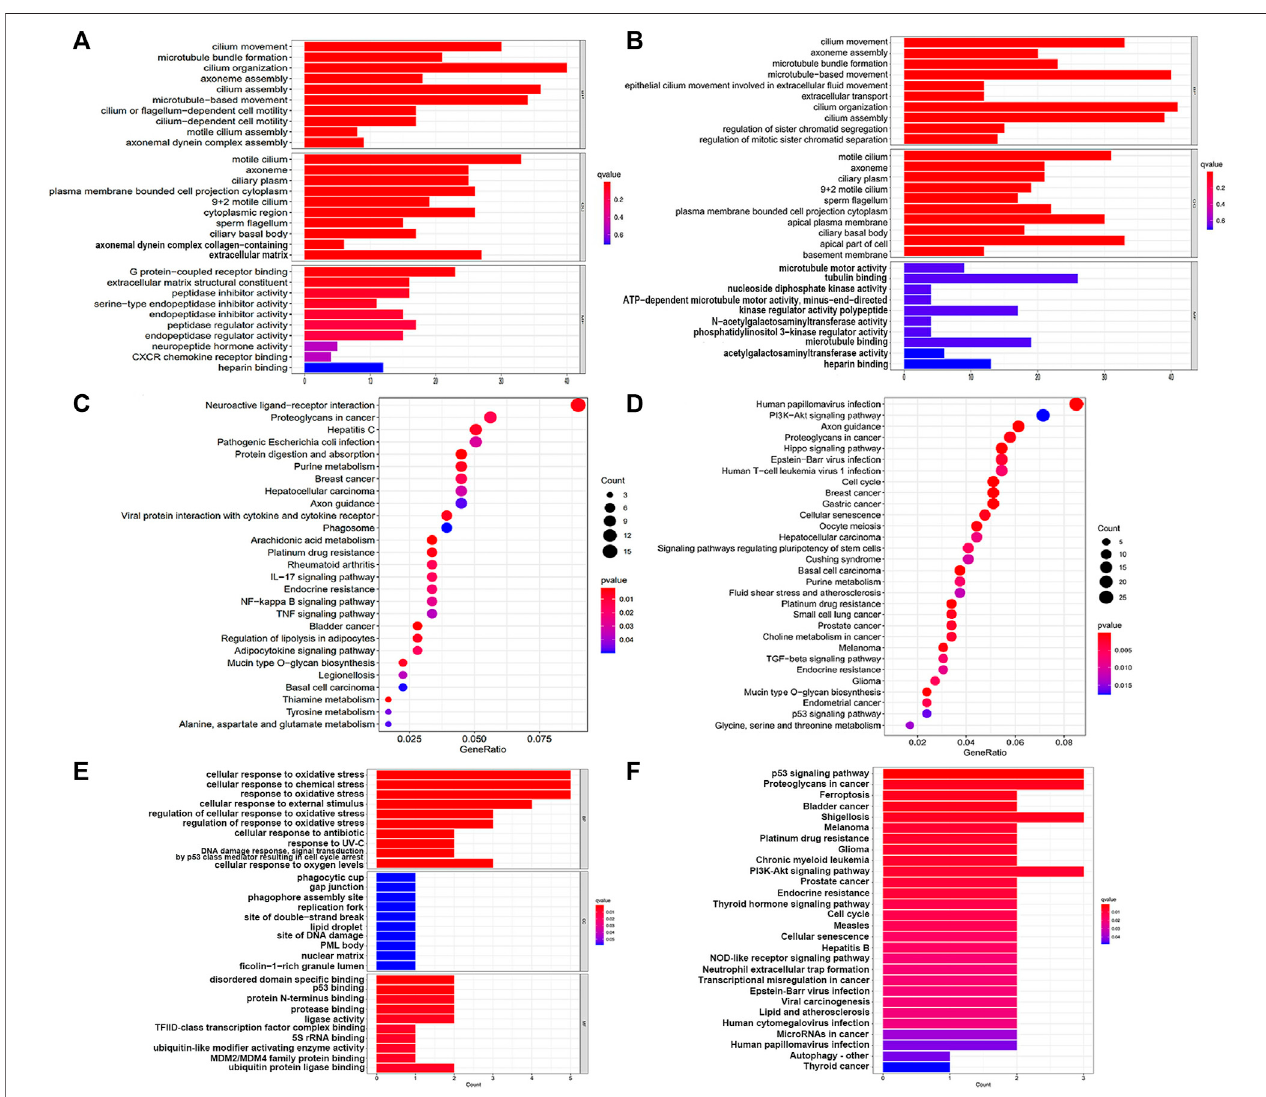
FIGURE 3 | GO and KEGG enrichment analysis results. (A , C) GO and KEGG pathway enrichment analysis in the training cohort; (B , D) GO and KEGG pathway enrichment analysis in the testing cohort; (E,F) GO and KEGG pathway enrichment analysis of the core genes in this signature.